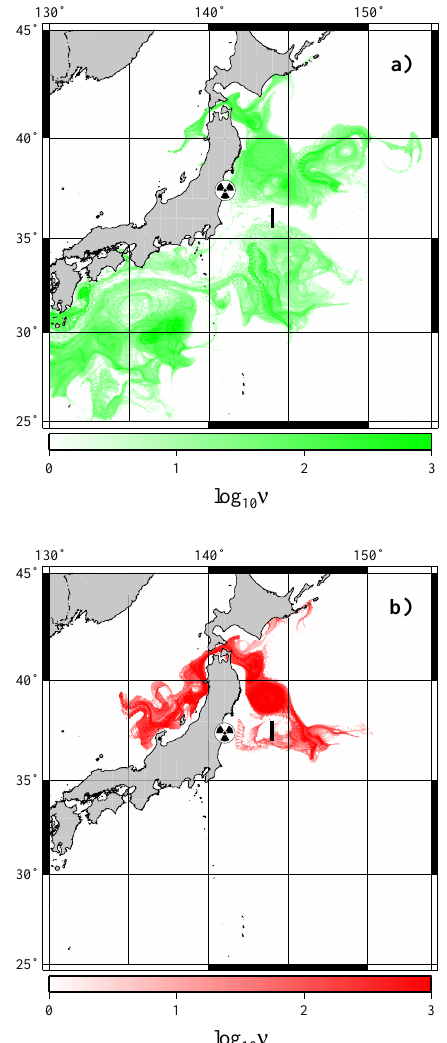
Fig. 6. Tracking maps for the markers placed on two material line segments along the transect where seawater samples have been col- lected on 10 and 11 June 2011 (Buesseler et al., 2012). The maps are colored as the corresponding segments in Fig. 2a and show where markers were walking from 11 March to 10 April 2011. Markers were initially placed along the 144 ◦ E meridian at the following seg- ments: (a) 35 ◦ 30 0 –36 ◦ 30 0 N and (b) 37 ◦ –38 ◦